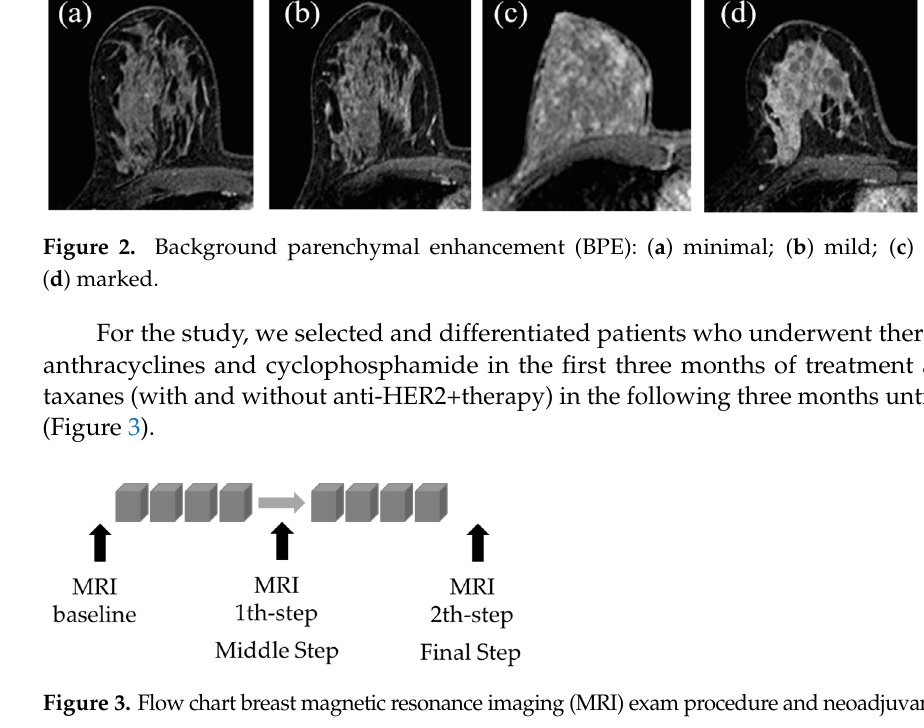
Figure 3. Flow chart breast magnetic resonance imaging (MRI) exam procedure and neoadjuvant